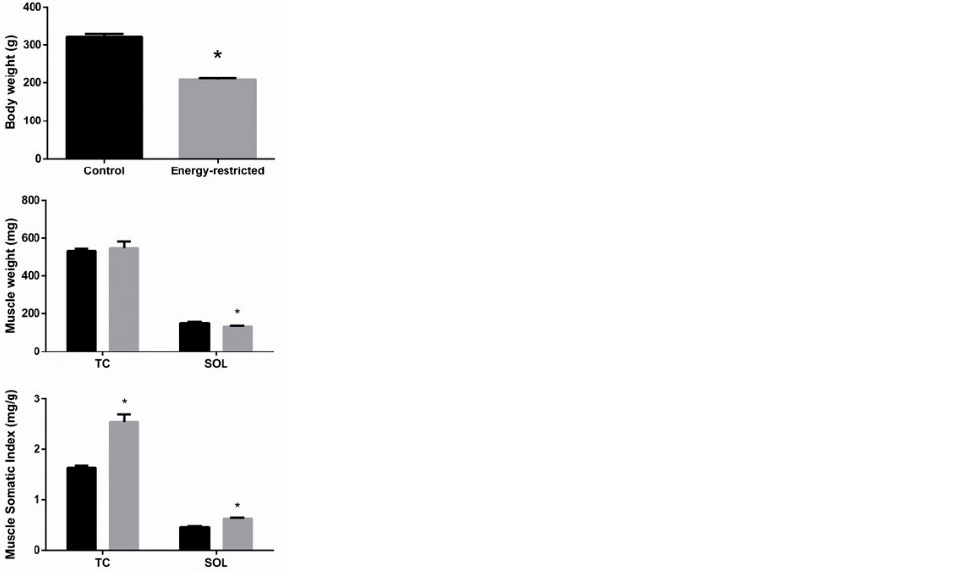
Figure 1. ( A ) Body weight at the time of sacrifice. ( B ) Tibialis cranialis (TC) and soleus (SOL) muscle weight, and ( C ) muscle somatic index. Student’s t-test between control (black bars) and energy-restricted (grey bars) groups. * p < 0.05 vs. control.